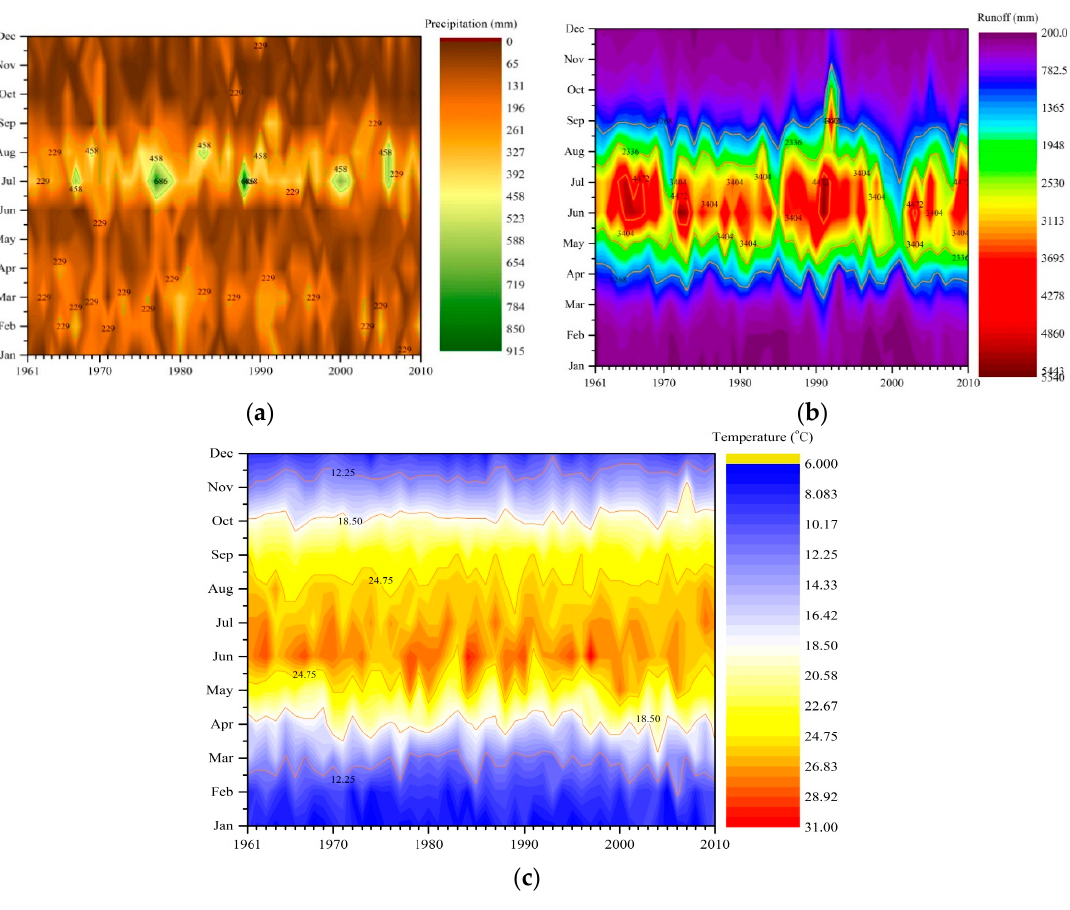
Figure 12. Contour plot of the precipitation, runoff and temperature for Zone II. ( a ) precipitation ( b ) runoff ( c ) temperature.